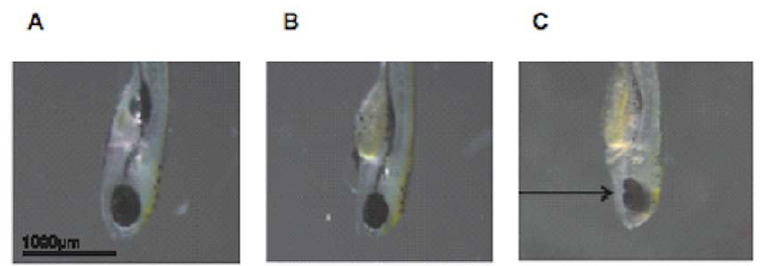
Figure 5. Reduced expression of zgc:110025 results in a small eye phenotype. Fig. 5A. Control injected, wild type zebrafish showing normal eye formation at 6 dpf. Fig. 5B. MO1 morphant zebrafish showing a small eye compared to control at 6 dpf. Fig. 5C. MO1 morphant zebrafish with co- injection of TMX3/(p.Arg39Gln), showing a small ocular coloboma (indicated by arrow) at 6 dpf. Fish are oriented with ventral surface facing left and dorsal surface facing right.